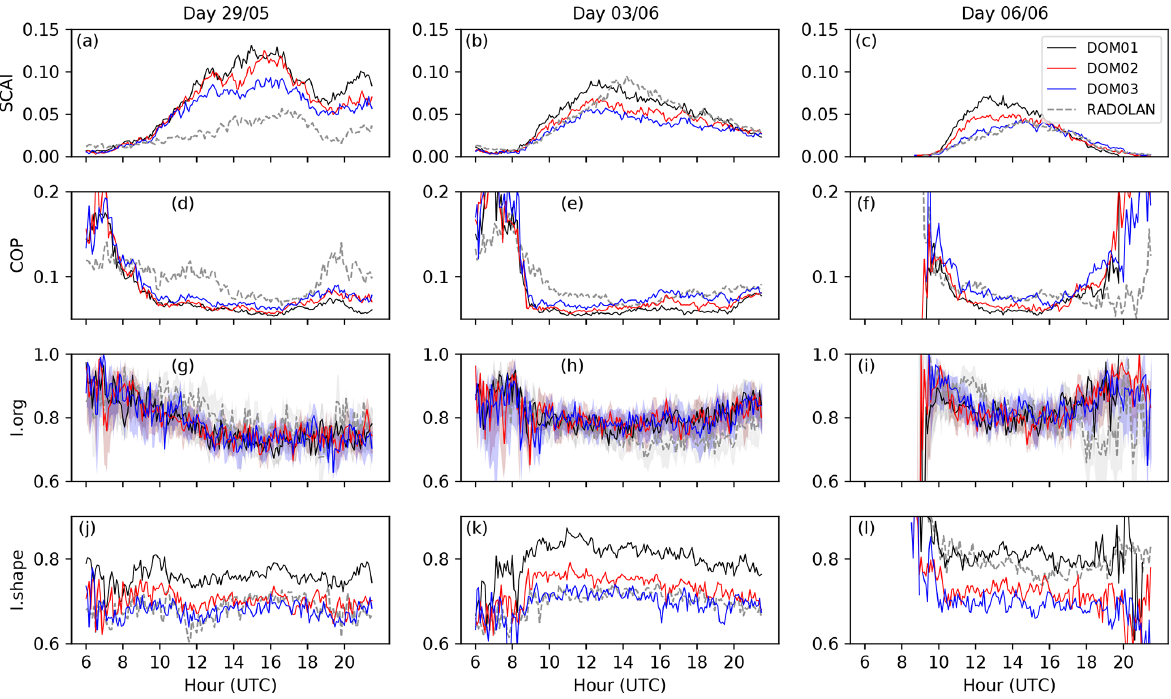
Figure 4. Convective organization indices SCAI (a–c) , COP (d–f) , median I org (g–i) , and I shape (j–l) for the days 29 May and 3 and 6 June 2016, for the three nests with 625m (DOM01), 312m (DOM02), and 156m (DOM03) grid spacing and the RADOLAN data. Averaging was carried out over all grid boxes within the 156m nest where radar data are available. Table 1. Ratio of the number of tracks of given track types (solitary, tracks that involve only merging, tracks that involve only splitting, and tracks involving both merging and splitting) and the total amount of rainfall that they contribute, relative to the total number and rainfall amount, respectively, of all tracks. Note that tracks that touch the domain boundaries are removed from the analysis. Fractions (in percent), including all 3 three-domain days, are given for all three domains with 625m (DOM01), 312m (DOM02), and 156m (DOM03) grid spacing and for the RADOLAN